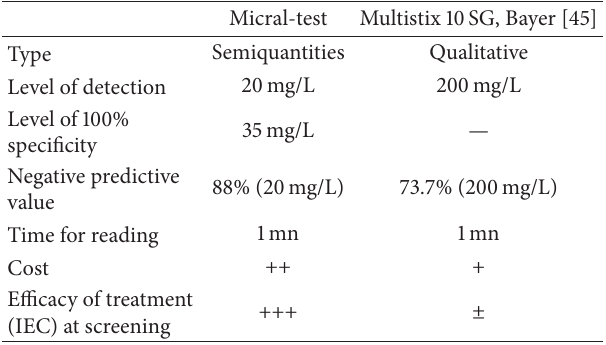
Table 5: Comparison of commonly used dipsticks for the detection of